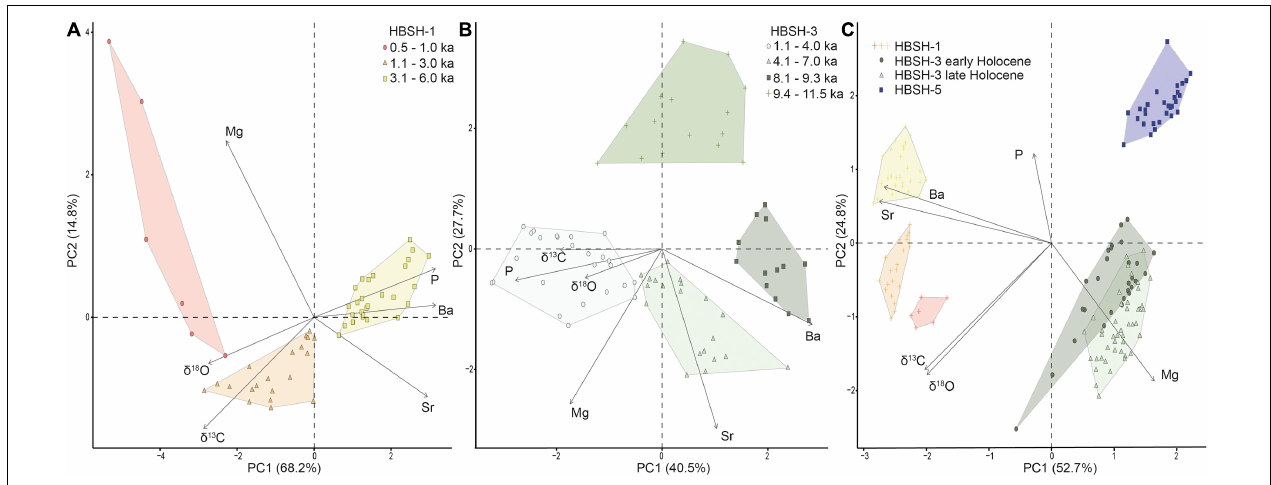
FIGURE 7 | Principal components (PCs) for stalagmites (A) HBSH-1, (B) HBSH-3, and (C) HBSH-1, HBSH-3 and HBSH-5. Since HBSH-5 did not pass the Kaiser-Meyer-Olkin test, only individual PCs for HBSH-1 and HBSH-3 are shown. Data points which are clearly separated from each other are grouped together with the same